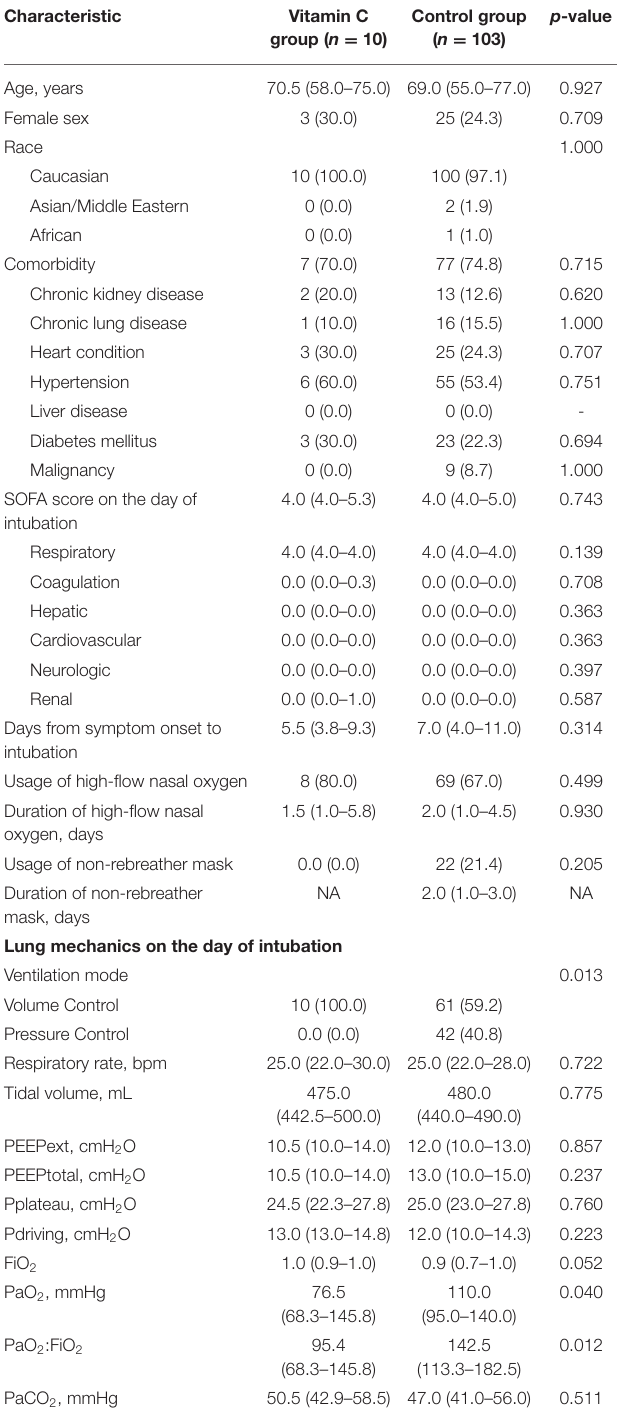
TABLE 1 | Baseline characteristics of patients included in the observational study. Characteristic Vitamin C